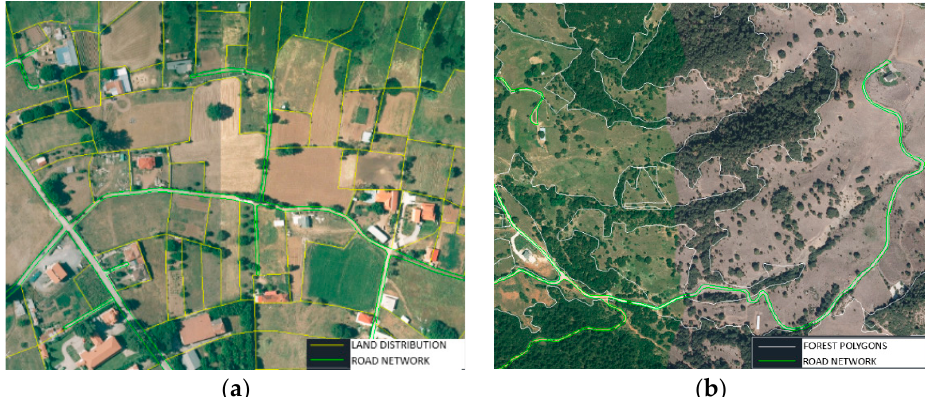
Figure 12. Geo-reference and digitization of ( a ) land distribution land parcels and ( b ) digitization of land parcels using photo-interpretation tools. Source: [35].